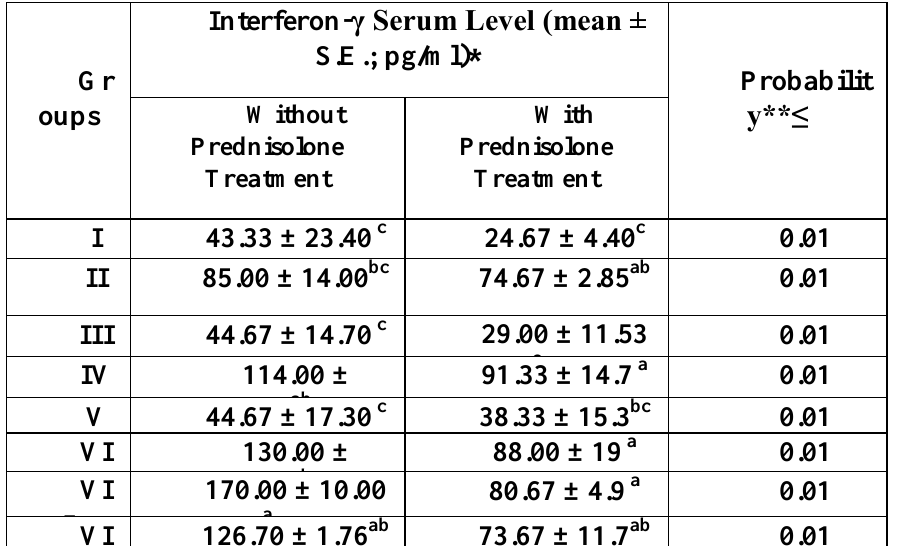
Table-2: Interferon-γ serum level by ELIZA in treated mice.